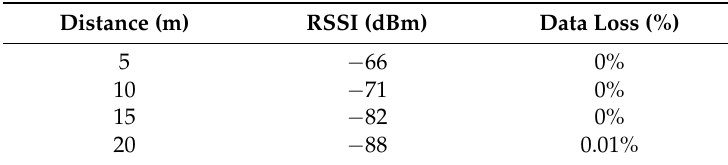
Table 2. Data Transmission in WMN of experiment A.